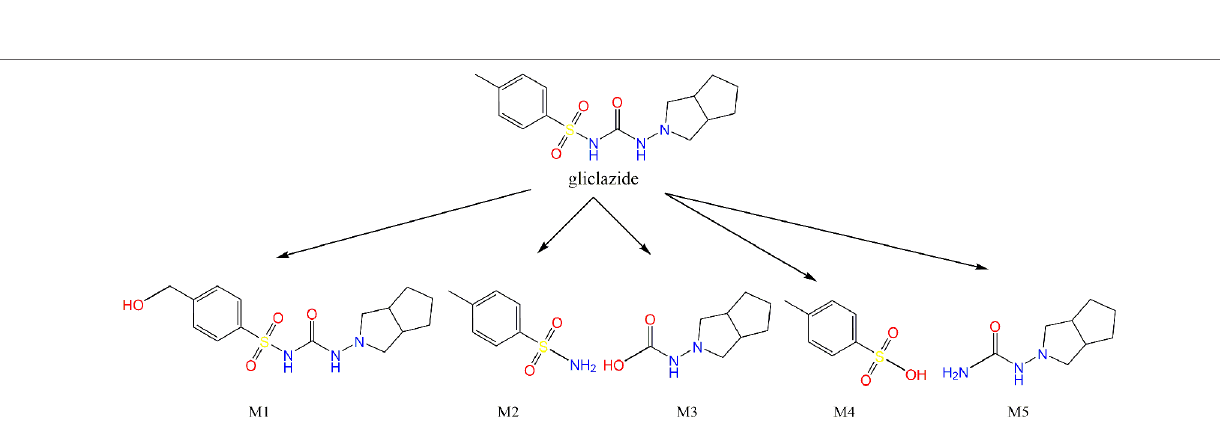
FIGURE 6 | Results obtained by EAWAG-BBD pathway prediction system. The metabolites obtained by hydroxylation (M1), hydrolysis of C–N (M2 and M3) and S–N bonds (M4 and M5) are shown.